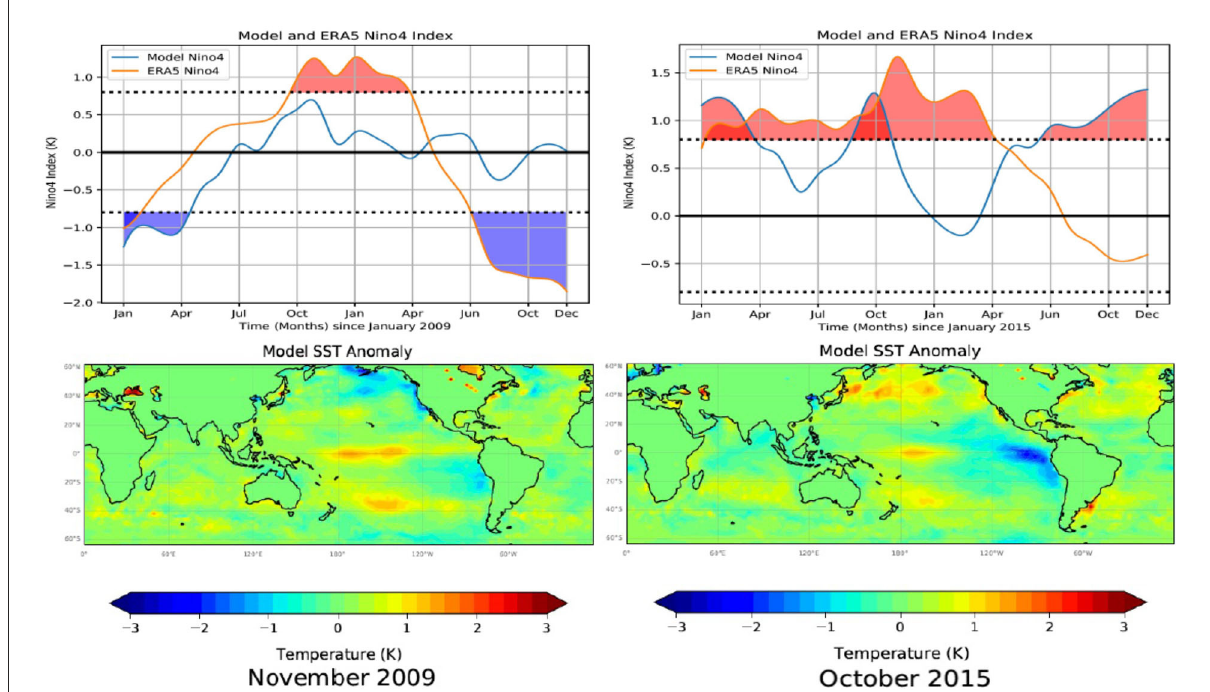
FIGURE12 Model predictions of the El Niño 4 index for the 2009-10 and 2015-16 warm periods are presented in the upper panels. In each graph, we compare the model results with the El Niño 4 index, defined as the monthly average SST computed over the region 5 ◦ N-5 ◦ S and 160 ◦ E-150 ◦ W, calculated from the monthly mean ERA5 SST data. The dotted lines define warm ( > 0.8 ◦ C) and cold ( < − 0.8 ◦ C) periods. Model predictions and ERA5 estimates of the El Niño 4 index > 0.8 ◦ C have been shaded red, and values < − 0.8 ◦ C have been shaded blue, for emphasis. The lower panels present the spatial pattern of the model predicted SST anomalies in November 2009 and October 2015 taken from the corresponding 24-month predictions shown in the upper panels. The 2009-10 El Nino is from the model training period, as there is no good example for a central Pacific El Nino during the model validation